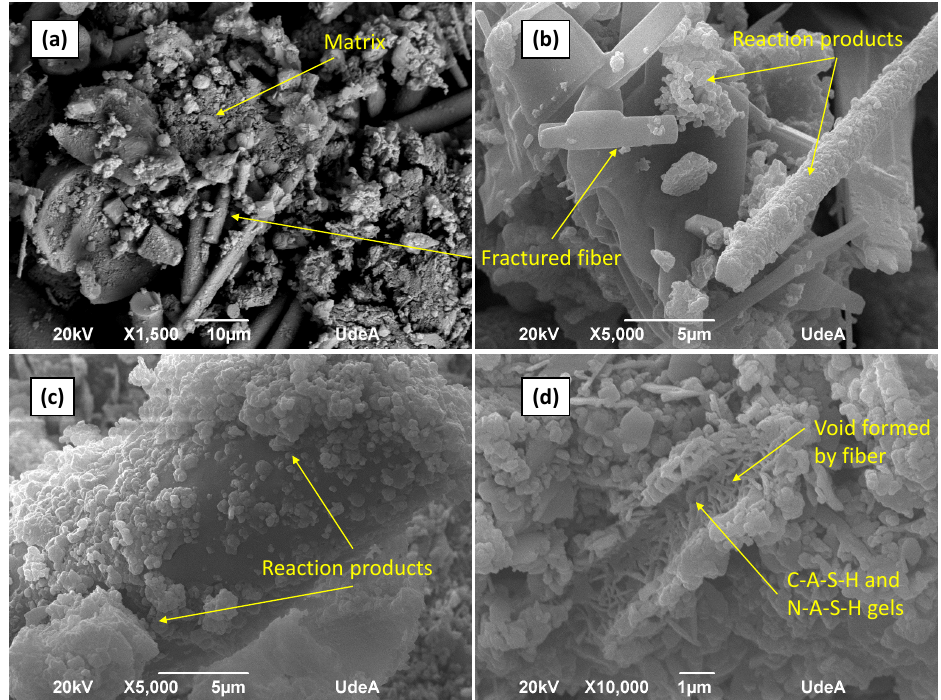
Figure 12. SEM images of alkali-activated cement combinations using Activator 1: ( a ) and ( b ) Act.1—0%, ( c ) Act.1—15% and ( d )